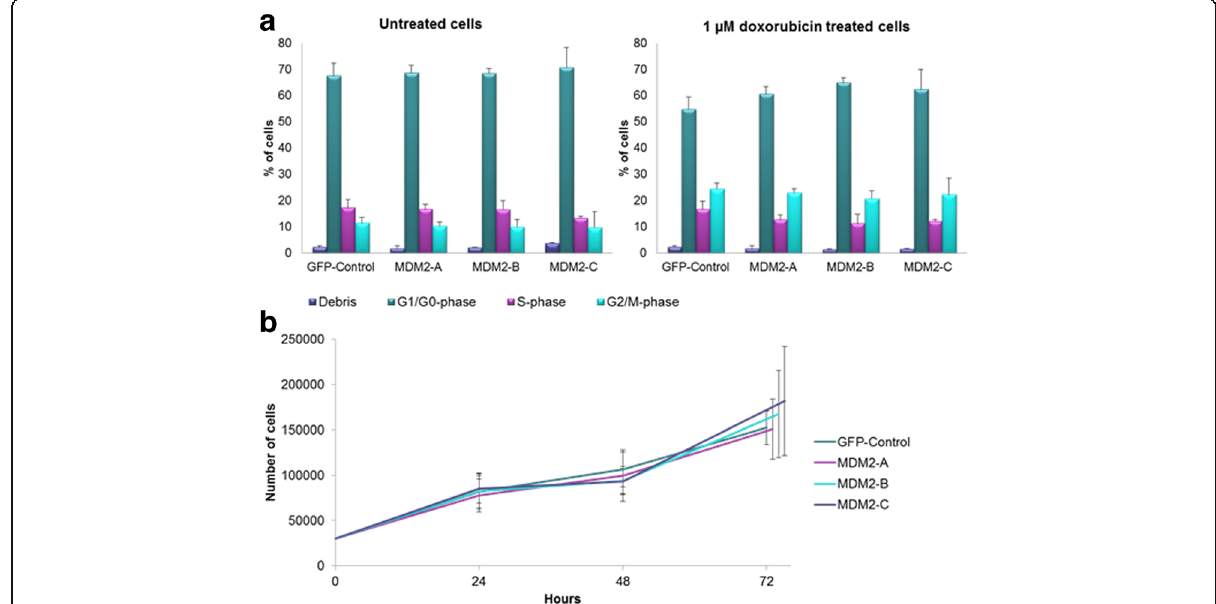
Fig. 6 Cell cycle analysis. ( a ) MCF-7 breast cancer cells were transfected with pCMV-GFP (GFP-control), MDM2-A, -B and -C. DMSO control cells ( left graph ) or cells treated with 1 μ M doxorubicin ( right graph ) for 24 h. The cells were analyzed by NucleoCounter-3000 for status of cell cycle progression. Bars represent cell debris ( purple bars ), cells in G1/G0-phase ( green bars ), cells in S-phase ( pink bars ) and cells in G2/M-phase ( blue bars ) respectively. ( b ) Cell proliferation analyzed by cell count. MCF-7 breast cancer cells transfected with pCMV-GFP (GFP-control), MDM2-A, -B and -C were counted to examine the cell proliferation 24, 48 and 72 h after transfection (data points at 72 h have been slightly shifted on the x-axis of the graph, for clarity). Both the experiments were repeated in triplicate, with three independent transfections